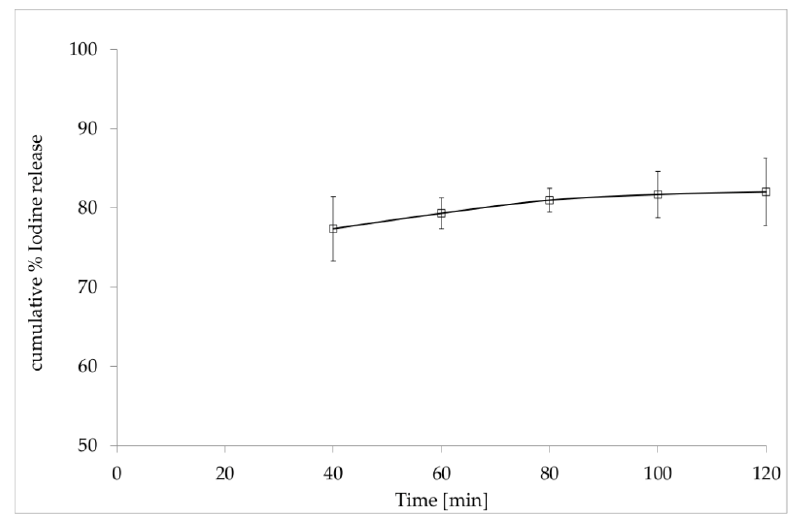
Figure 4. In vitro release profile of iodine (I 2 ) from PVA / HPMC_B film (with incorporated PVP-I) versus time.